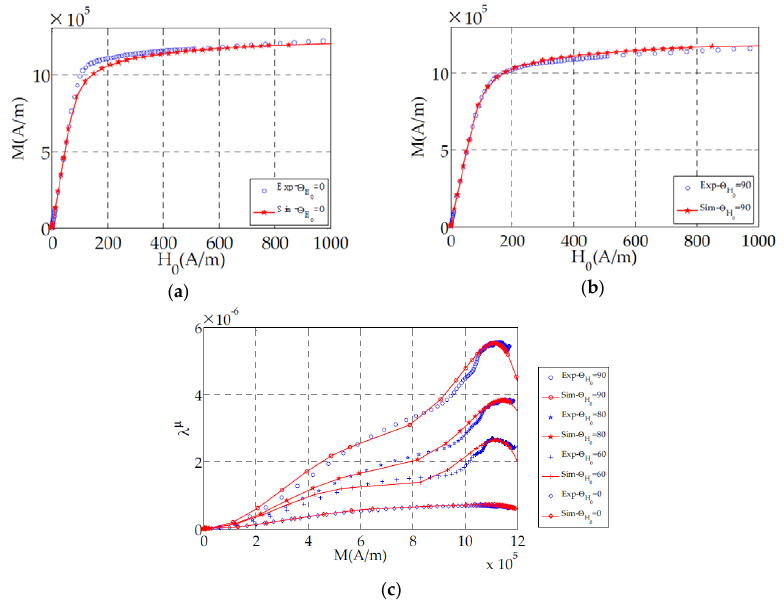
Figure 4. ( a,b ) Non-hysteretic (anhysteretic) plotted magnetization curves along RD (0°) and TD (90°); ( c ) Longitudinal magnetostriction in different magnetic field directions.